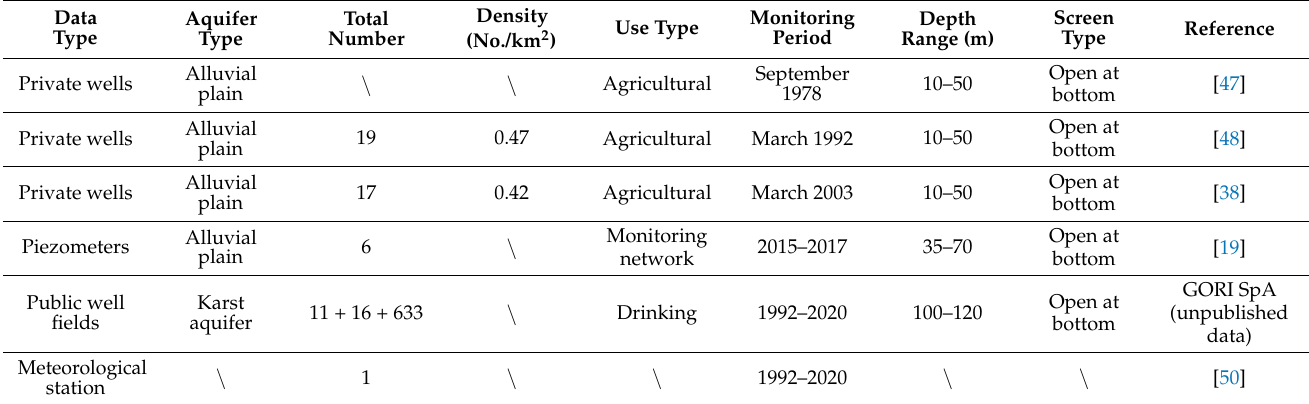
Table 1. Hydrogeological data collected for the study